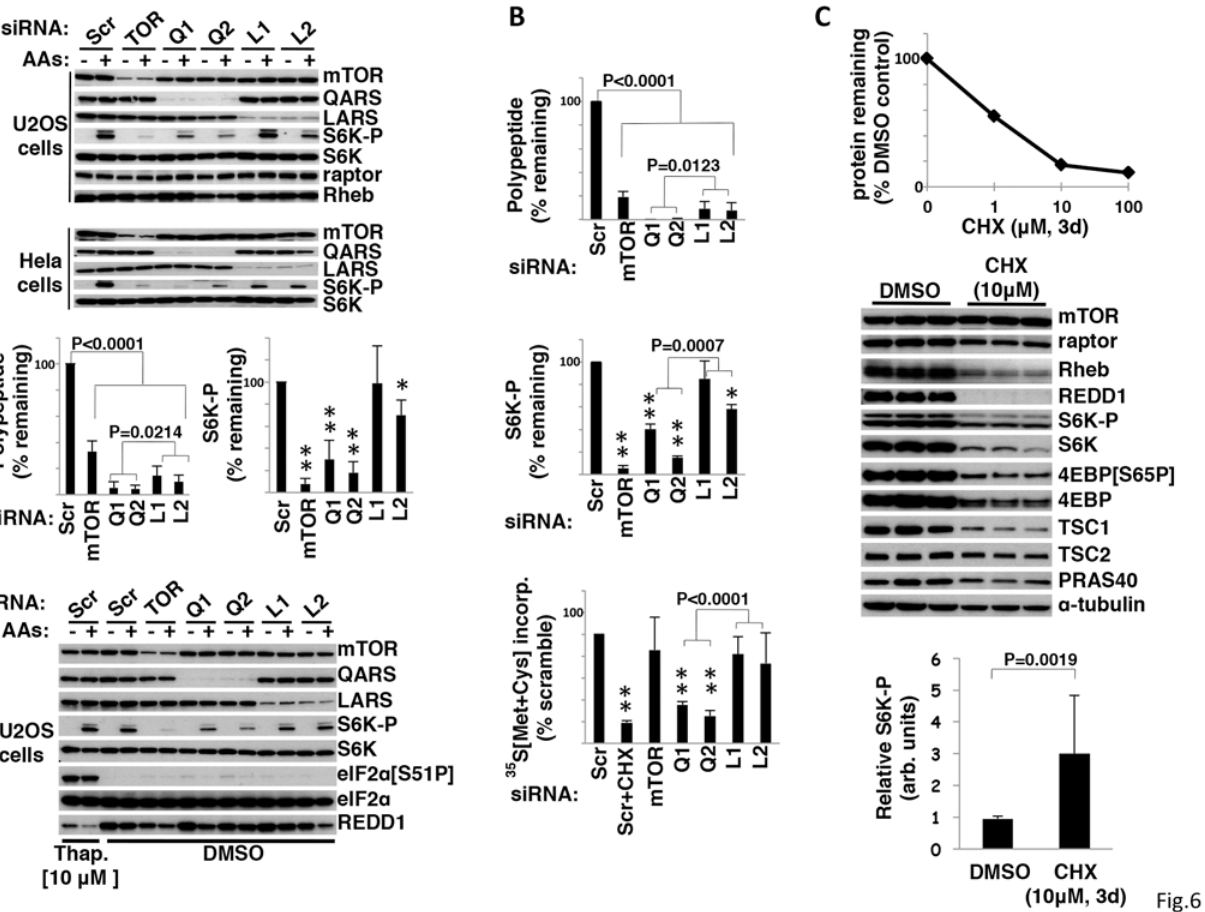
Fig 6. siRNA-mediated depletion of QARS inhibits mTORC1 signaling. A. The effect of mTOR, QARS and LARS siRNA upon polypeptide knockdown and S6K-Thr 389 phosphorylation. U2OS and Hela cells were transfected with siRNA oligos against mTOR, QARS (Q1,Q2), LARS(L1,L2) and a scramble control. After 72h amino acids were withdrawn for 2 hours and added back for 15 minutes as indicated. Cells extracts were subjected to SDS-PAGE and membranes were immunoblotted with the antibodies as indicated. The bar graphs display the combined results of three experiments (mean-/+ 1 S.D.; ** = p<0.0001 and * = p<0.002 vs scramble) The experiment shown in the bottom panels compares the effects of Thapsigargin (10M) with the indicated siRNAs on S6K-P (fourth from top), eIF2 α (Ser51-P) (third from bottom) and the abundance of REDD1 (bottom). B. siRNA-mediated depletion of QARS inhibits global protein synthesis. Graphical representation of the combined results from three experiments (mean-/+ 1 S.D.) examining the effect, relative to scramble siRNA, of siRNA against mTOR, QARS and LARS on the abundance of the target polypeptides (upper), the relative phosphorylation of S6K-P (middle; ** = p<0.0001 and * = p<0.002 vs scramble) and on overall protein synthesis (bottom) in nutrient and serum replete U2OS cells. Analyses were carried out three days after transfection. 35 S[Methionine+cysteine] was added two hours before harvest; cycloheximide (CHX, 100 μ M) or carrier was added 30 ′ prior to 35 S. C. The effect of inhibiting translation for three days on mTORC1 signaling. Graphical representation of a dose response of cycloheximide (CHX) on global protein synthesis in U2OS cells. U2OS cells were plated in DMEM with 10% FCS +/- CHX and fresh media containing carrier or CHX was added every 24 hours for 72 hours. The cell were harvested at 72 hours; protein content expressed as a fraction of carrier control is plotted in the upper graph. Immunoblots of cell extracts for the proteins indicated are shown in the middle and the ratio of S6K-P/S6K (mean-/+ 1 S.D.) is shown in the bar graph at the bottom.